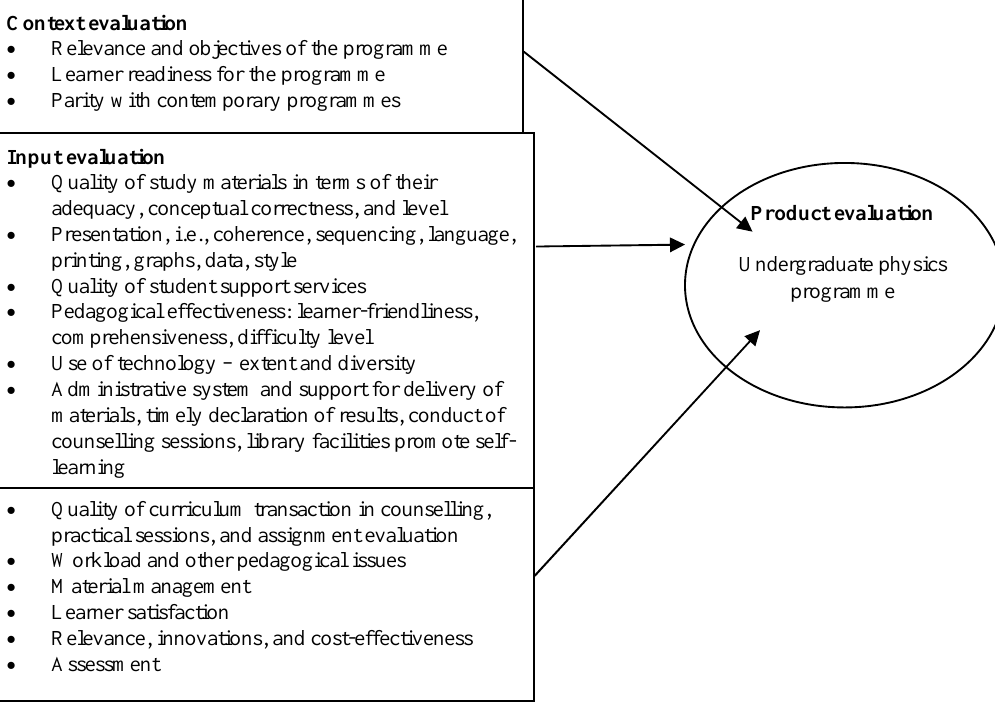
Figure 1 . Conceptual framework for evaluation of undergraduate physics programme of